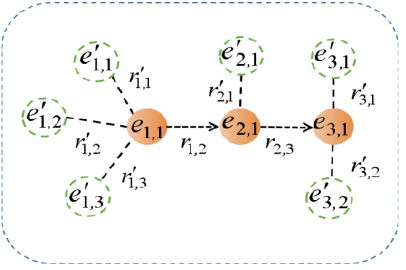
Figure 1. DIVA path feature generation process diagram.